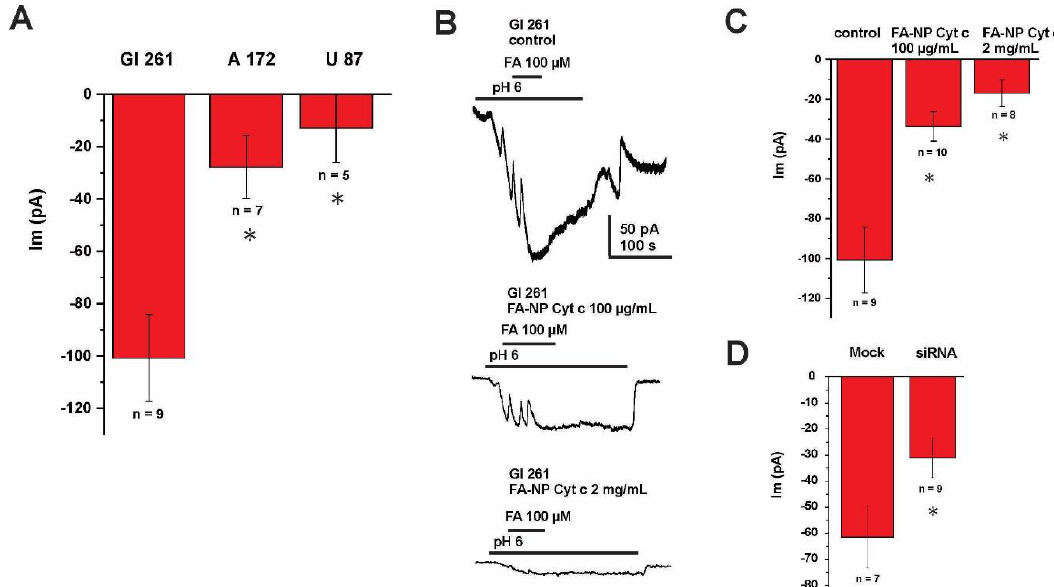
Figure 3. FA-induced membrane currents recorded from glioma cells. ( A ) Summary of currents recording from GL261, A172 and U87 glioma cells using whole-cell voltage clamp (held at –60 mV), elicited by addition of FA (100 µM) to the extracellular solution (pH 6.0). ( B ) Representative current recording and the summary of currents ( C ) from GL261 glioma cells using whole-cell voltage clamp (held at –60 mV), elicited by addition of FA (100 µM) to the extracellular solution (pH 6.0). The recording was performed with or without extracellular addition of FA-Cyt c NPs, given at different concentrations. ( D ) Summary of currents recorded from mock-transfected GL261 cells and cells transfected with siRNA against the PCFT, both induced by application of FA. Error bars represent SEM. * indicates a significant difference ( p < 0.05). n is the number of cells investigated. Immunocytochemical experiments revealed the robust expression of the PCFT in GL261 and A172 cells, but not in astrocytes (Figure 4A). Expression of PCFT in A172 cells were lower compared to GL261, but significantly higher compared to U87 cells. U87 cells showed the lowest level of PCFT expression in investigated glioma cell lines. These results were confirmed by quantitative reverse transcription-polymerase chain reaction (RT-PCR), indicating a low PCFT gene expression in astrocytes, limited PCFT gene expression in U87 human glioma cells, higher expression in A172, and strong PCFT expression in GL261 cells (Figure 4B). Some limited expression of PCFT was detected in a whole cortex tissue in mice, which is, however, significantly lower compared to the mouse GL261 glioma cells. No significant expression of folate receptor 1 (FOLR1) was detected in glioma cells. Kidney and gut tissues from mice were used as a positive control for PCFT gene expression, as these tissues are shown to have a high level of PCFT and FOLR1 expression [30,31].